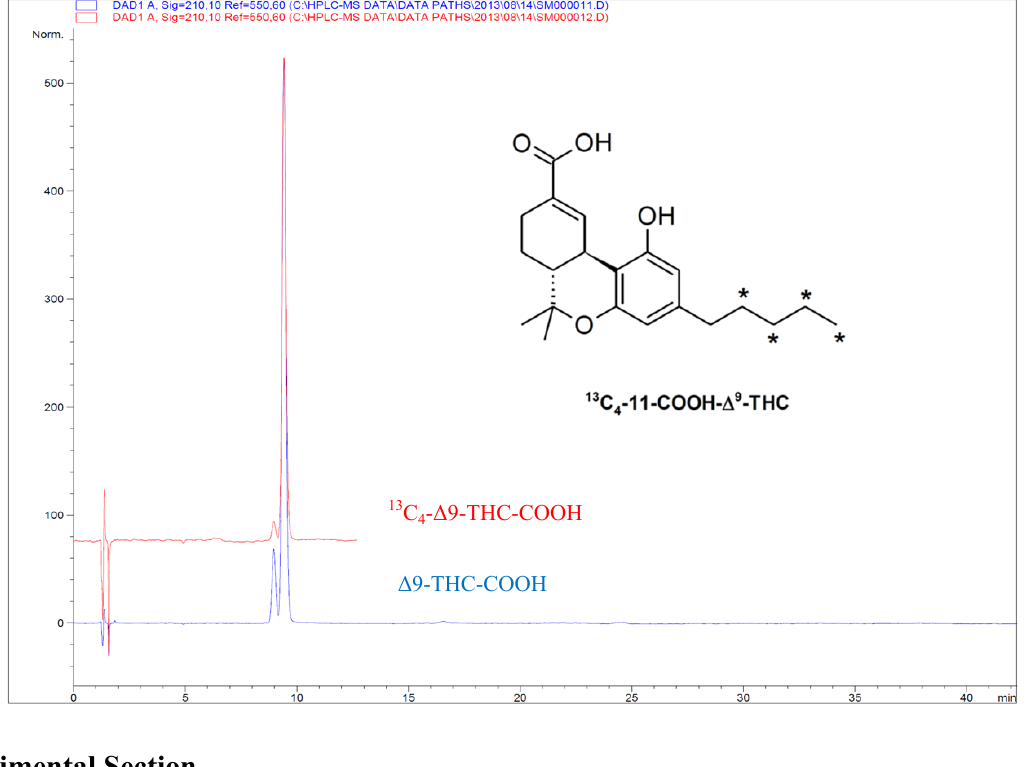
Figure 2. LC chromatogram of [ 13 C COOH. The impurities are [ 13 C